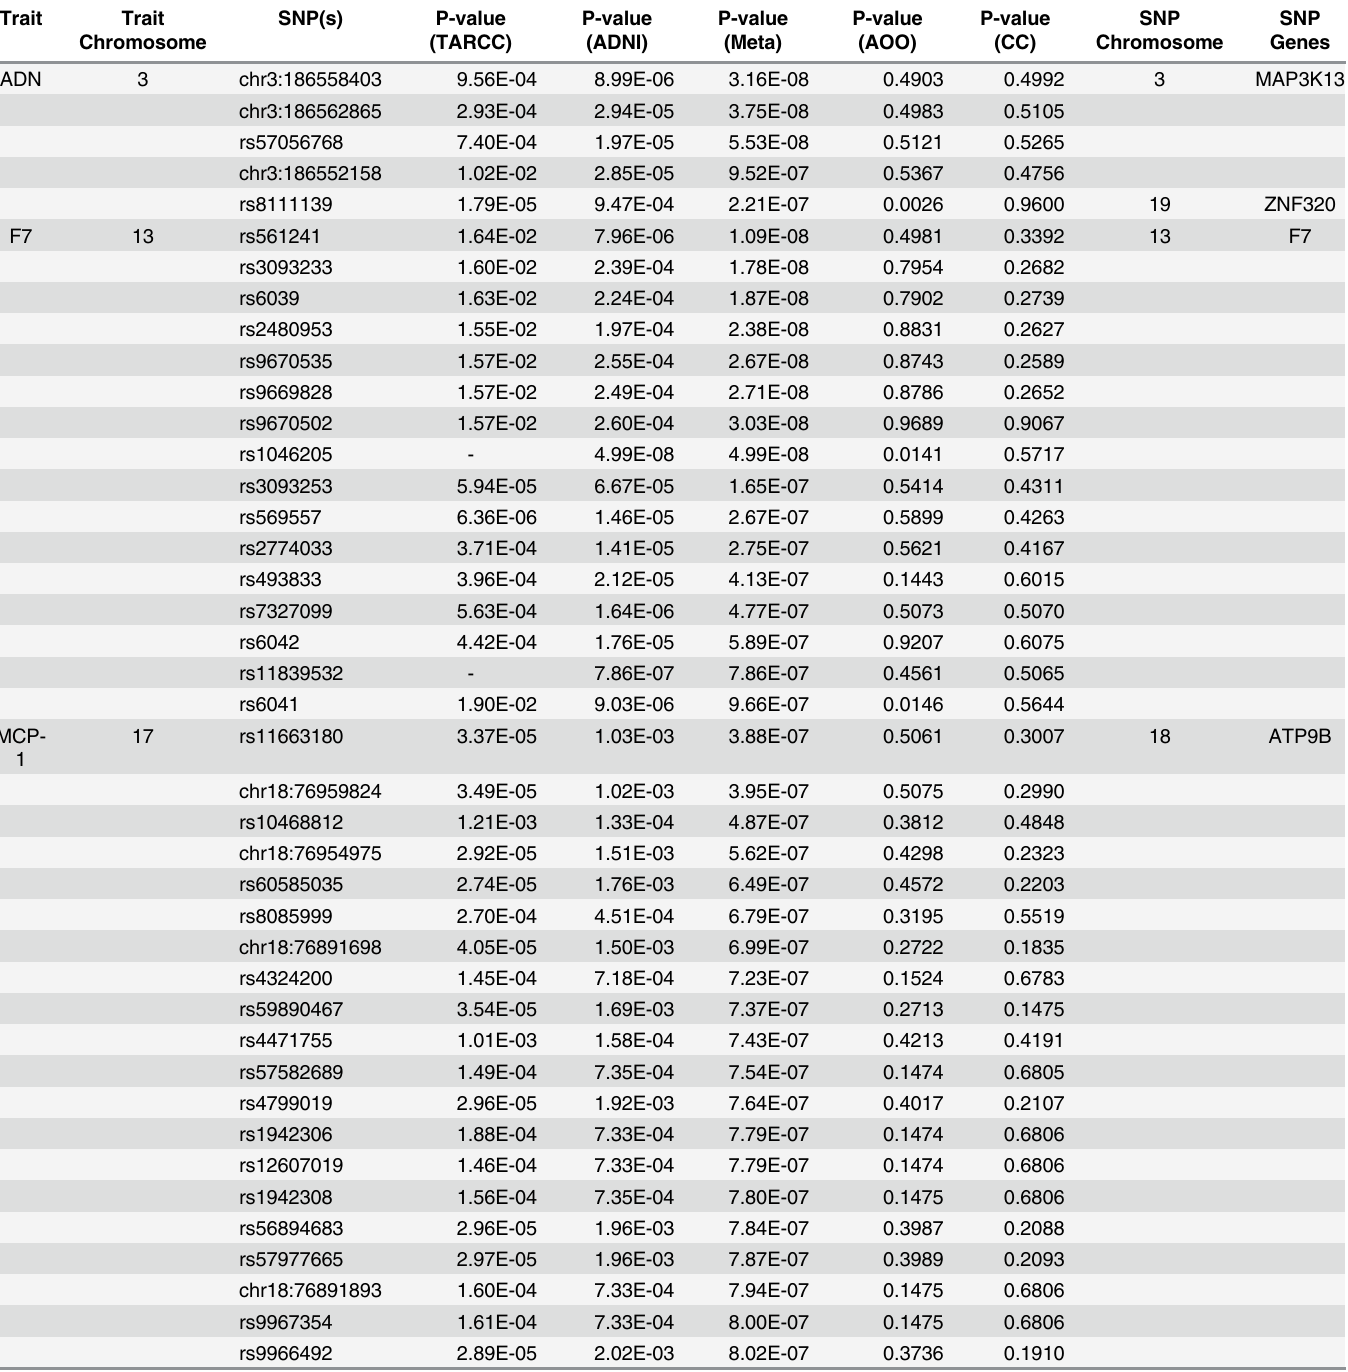
Table 3. Genome-wide significant signals for each endophenotype. P-values, chromosomal and gene location are presented for each signal from the meta-analyses (Meta) and from the individual (ADNI) and (TARCC) cohorts. P-values are also shown for the association between each endophenotypic sig- nal and age of onset (AOO) and case-control status (CC).